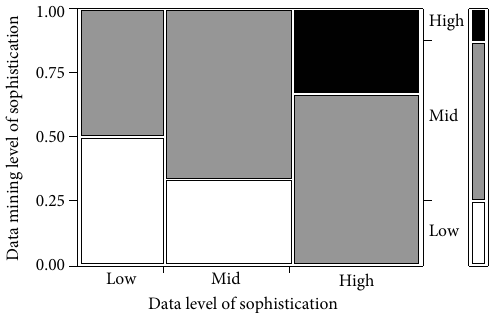
Fig. 4. Relationship between data level of sophistication and data mining level of